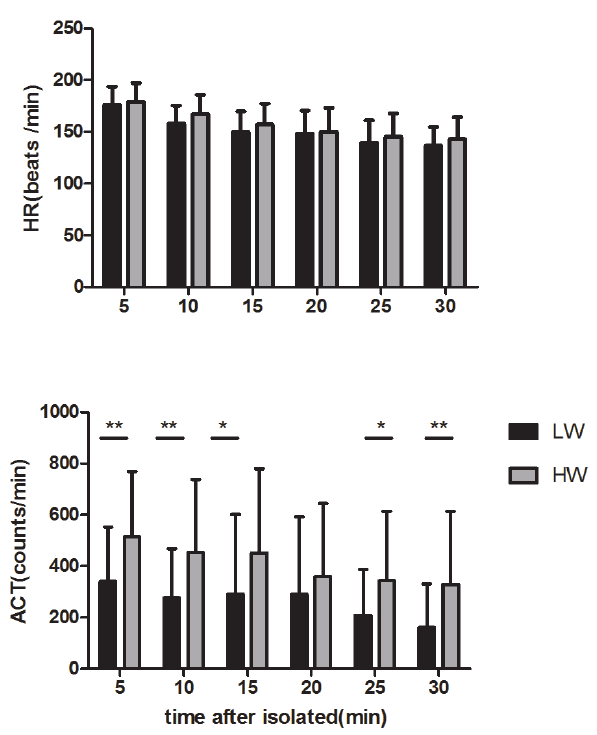
Figure 2. Comparison in heart rate (HR) and activity count (ACT) between the low litter weight (LW) and high litter weight (HW) litters litters in piglets (calculated every 5 min). The asterisk (*) means a significant difference with p<0.05; the asterisk (**) means very significant difference with